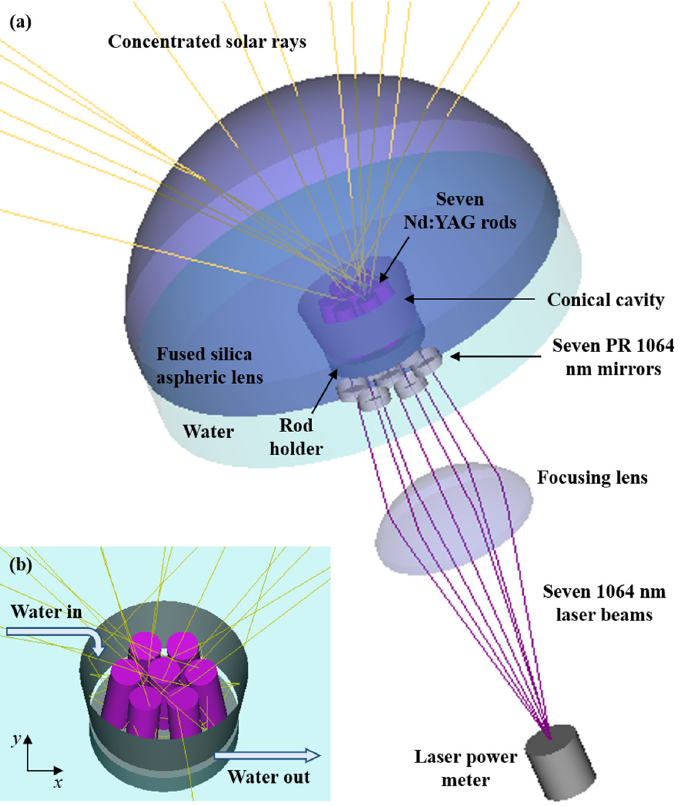
Figure 3. Three-dimensional view of ( a ) the solar laser head and ( b ) the conical pump cavity with seven Nd:YAG rods.